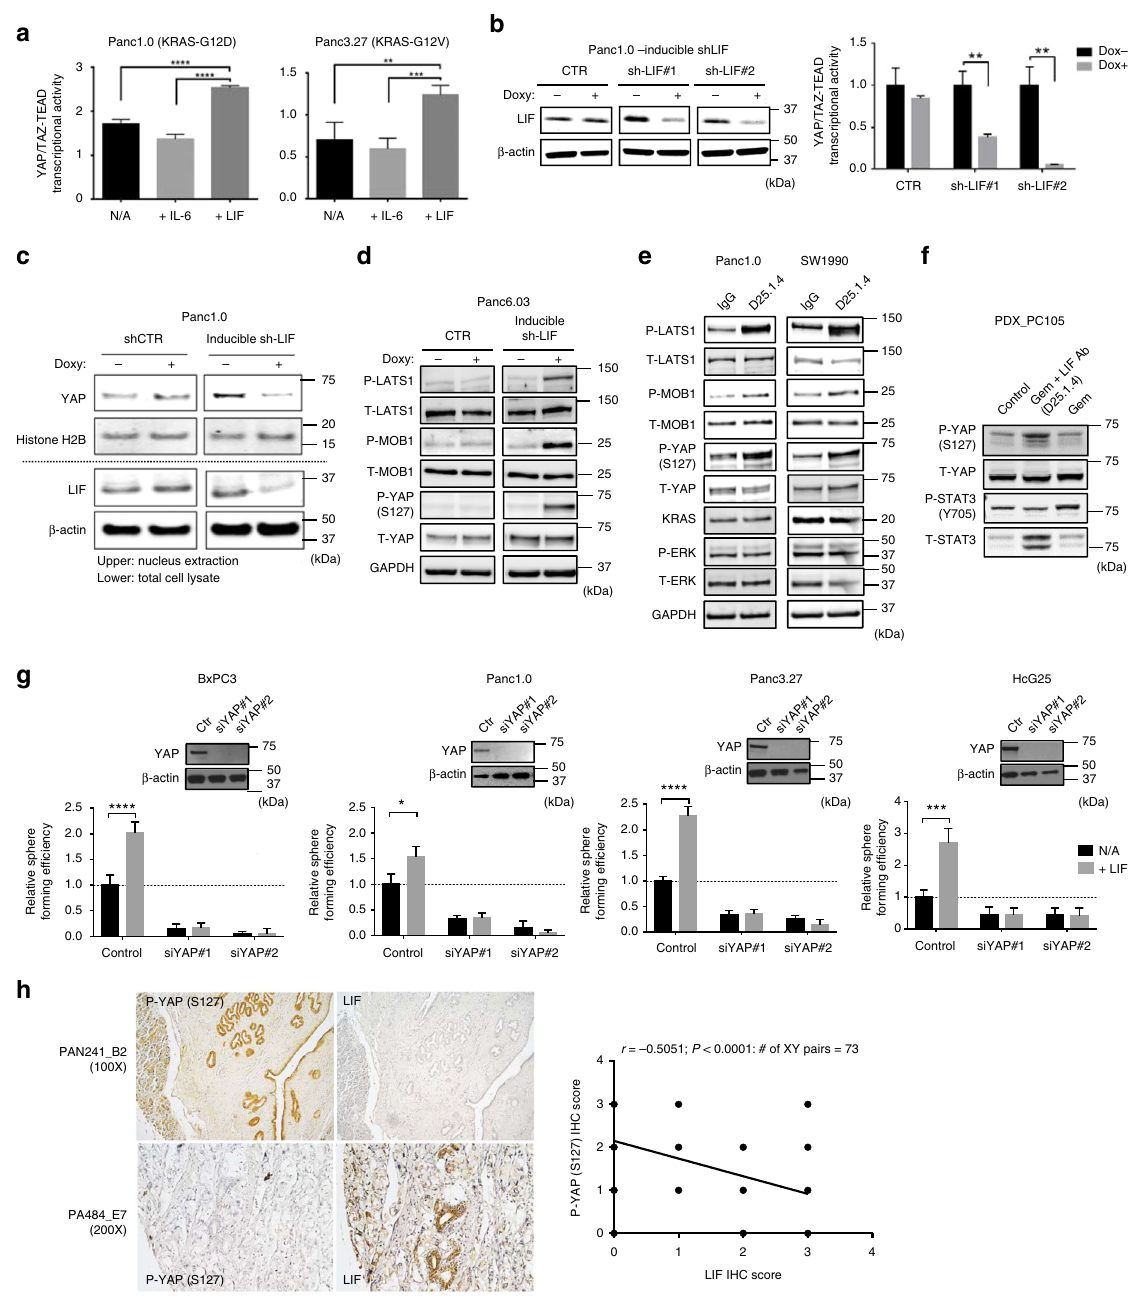
RasGTP pull-down assay . Cells were washed twice in ice-cold PBS and lysed in 1% TX100-TNM lysis buffer (20mmol/L Tris pH 7.5, 5mmol/L MgCl2, 150mmol/L NaCl, 1% Triton X-100) supplemented with 1mmol/L DTT, and protease and phosphatase inhibitors (Sigma – Aldrich). Equal amounts of protein from each sample were added to 10µL of packed GST-Raf-RBD or Ral-GDS-RBD beads in 300 – 500µL of 1% TX100-TNM lysis buffer and rotated at 4°C for 1 – 2h. Beads were washed three times with 1mL of cold lysis buffer and boiled in lithium dodecyl sulfate (LDS) sample buffer (Invitrogen). Sphere formation . Cells were harvested, counted and seeded onto Ultra Low Attachment Culture 96-well plates (Corning Life Science, Catalog number 3261) at 100 or 1000 per well. The seeded cells and formed spheres were maintained in low- serum-containing medium with 0.1% FBS. The initiated spheres were observed twice a week, with the number of formed spheres counted one month after seeding. LIF ELISA . The level of human LIF in culture medium was determined by human LIF ELISA kit (Invitrogen Cat. No. BMS242). An anti-human LIF antibody was